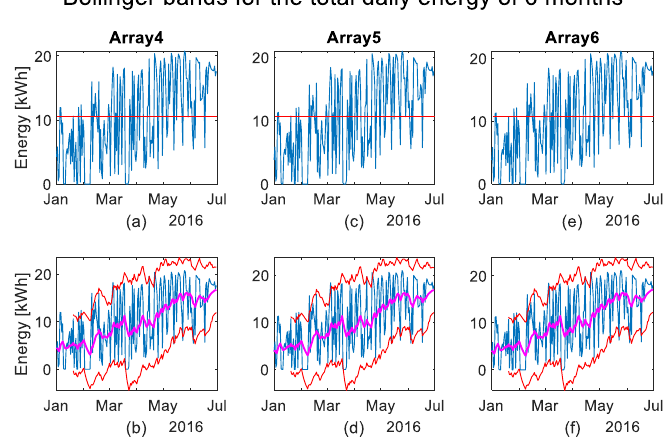
Figure 5. ( a ) Energy produced by array #1 in six months and its mean value as red line; ( b ) upper and lower BB 20 of array #1 in red color, and EMA 20 in magenta color. ( c ) and ( d ) refer to array #2. ( e ) and ( f ) refer to array #3.